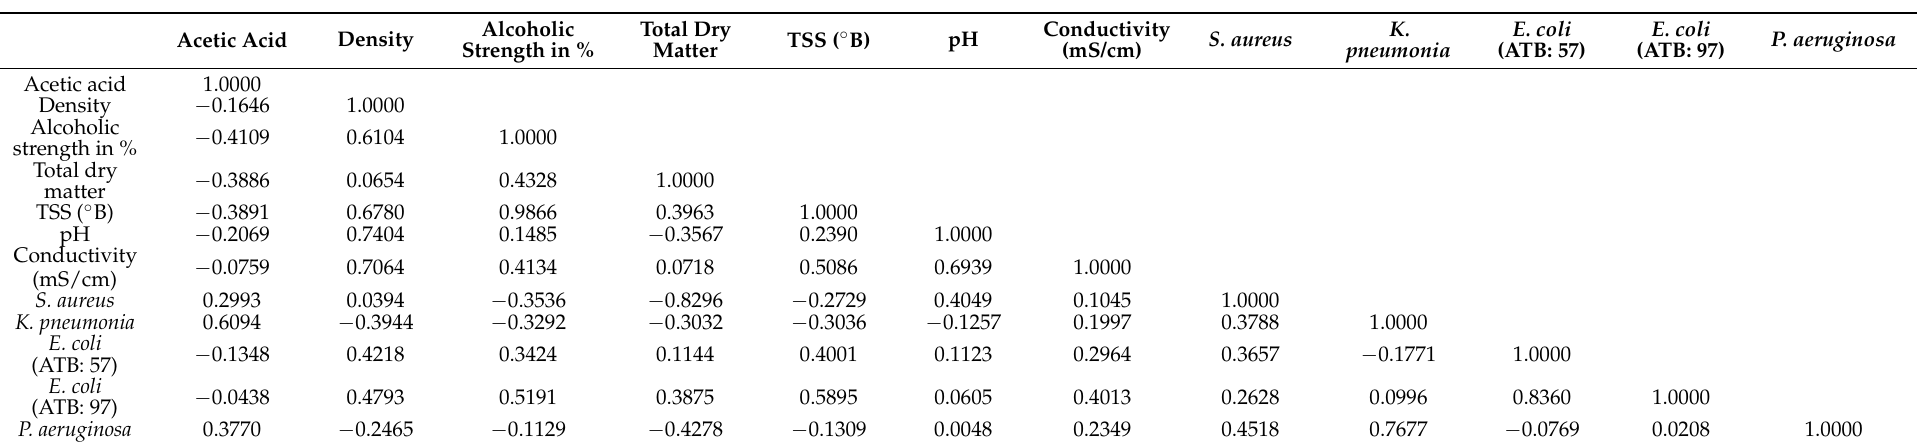
Table 4. Pearson correlation coefficients between different parameters of apple